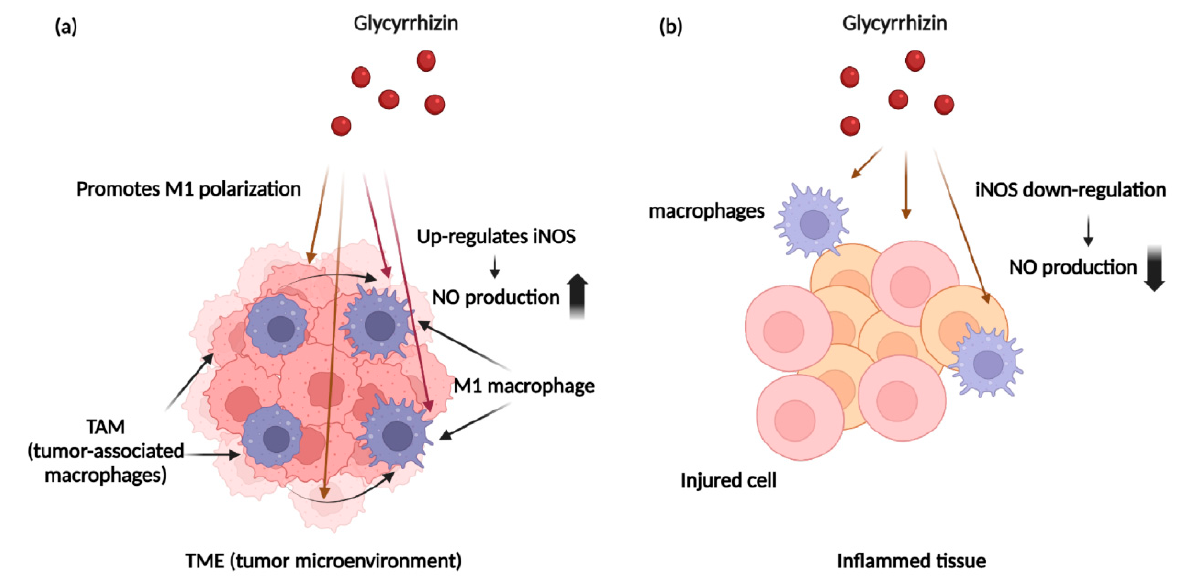
Figure 5. Mechanisms by which GL acts as an NO regulator. Image created with BioRender icons. ( a ) GL induces polarization of TAMs to the M1 phenotype and upregulates iNOS expression of M1 TAMs, resulting in increased NO production; ( b ) NO acts as pro-inflammatory cytokine and induces inflammation in inflammatory diseases. GL downregulates NO production via reducing iNOS expression of cells of inflamed tissue.